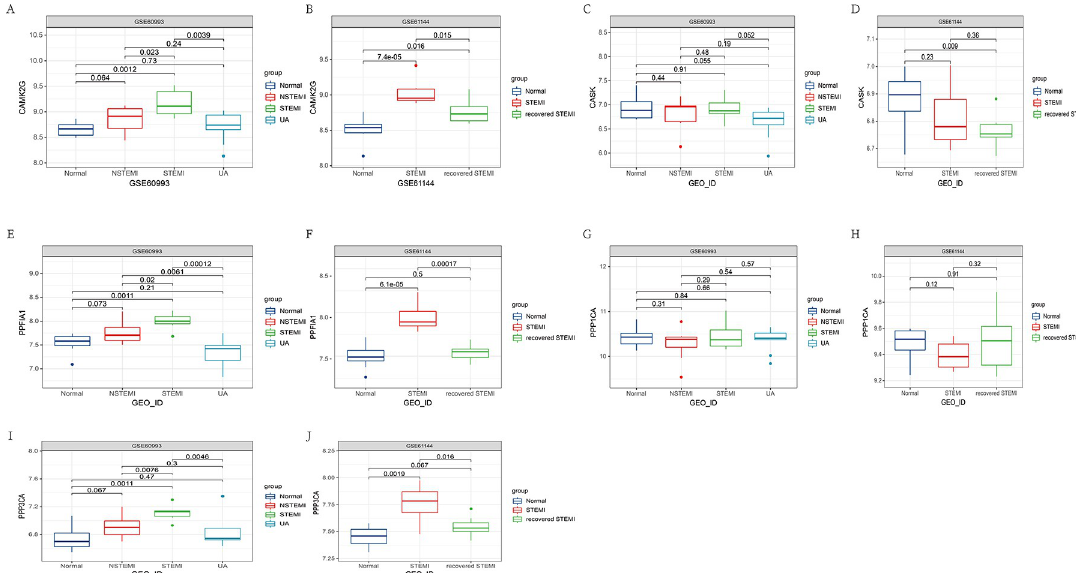
Fig 3. A. Box plot of the expression of CaMK2G in GSE60993. B. Box plot of CaMK2G in GSE61144. C.Box plot of the expression of CASK in GSE60993. D.Box plot of the expression of CASK in GSE61144. E. Box plot of the expression of PPFIA1 in GSE60993. F. Box plot of the expression of PPFIA1 in GSE61144. G. Box plot of the expression of PPP1CA in GSE60993. H. Box plot of the expression of PPP1CA in GSE61144. I. Box plot of the expression of PPP3CA in GSE60993. J. Box plot of the expression of PPP3CA in